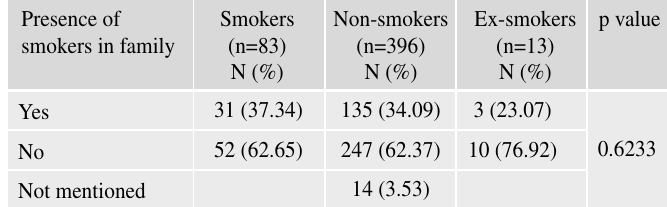
Table III: Number of sticks taken by the study subjects